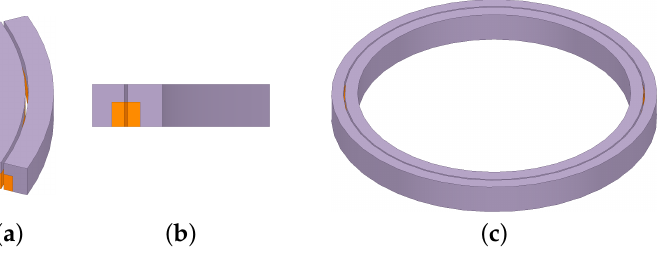
Figure 7. Electromagnetic model of the rotary transformer in ANSYS Maxwell: ( a ) shows top view and ( b ) shows front view of a generic slice of the transformer, whereas ( c ) shows the complete 3D